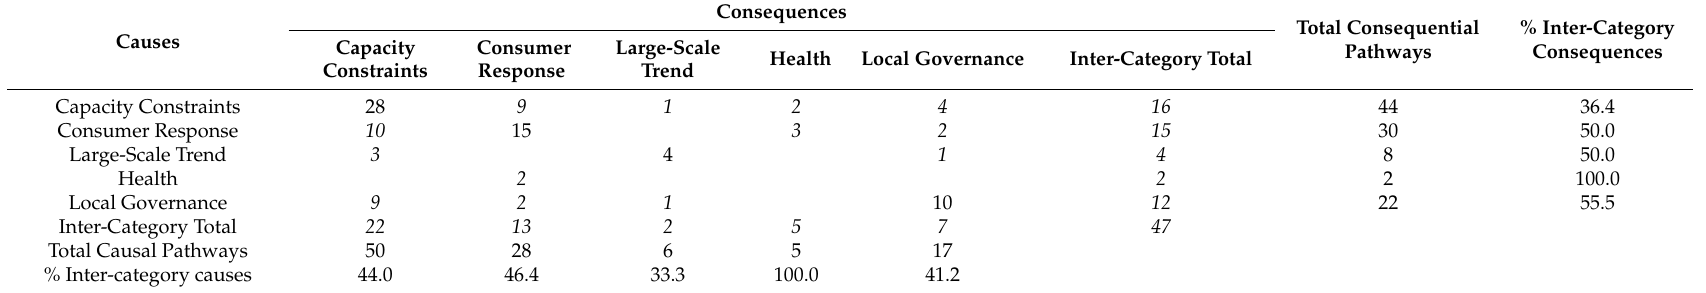
Table 3. Counts of pathways between